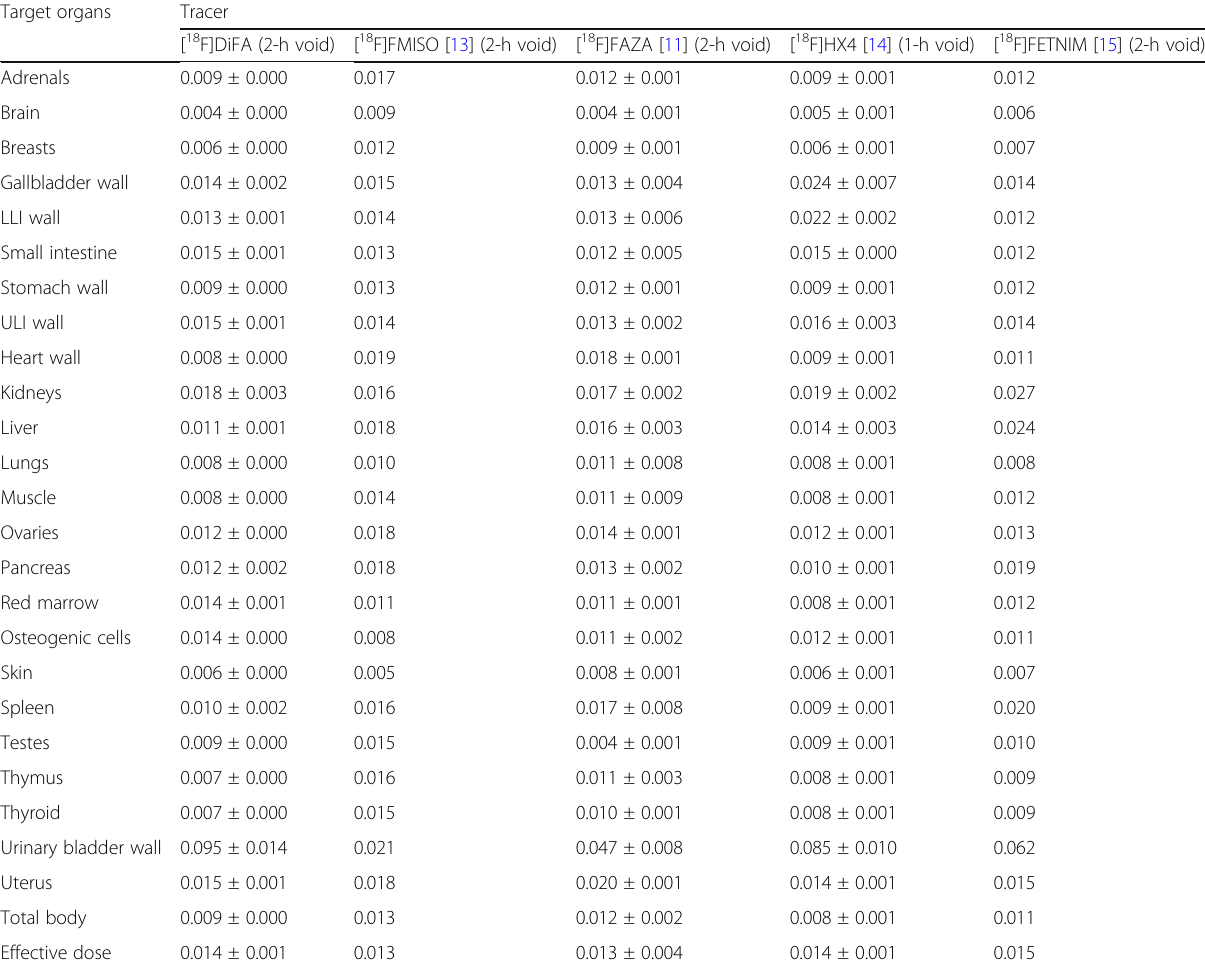
Table 4 Equivalent doses of [ 18 F]DiFA, [ 18 F]FMISO, [ 18 F]FAZA, [ 18 F]HX4, and [ 18 F]FETNIM to target organs Target organs